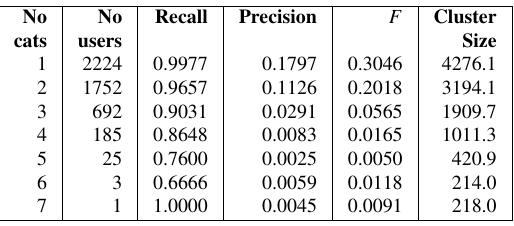
Table 4. Dependence f simple ⊆ classifier performance from num- ber of categories present in cluster, with threshold t = 30.